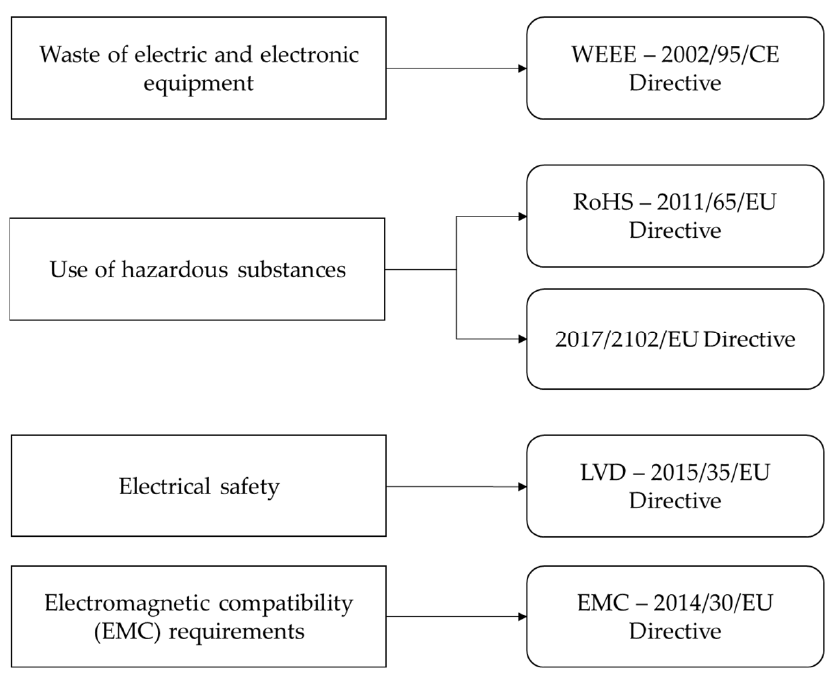
Figure 1. Directives of general application to be considered in the development of BPL electronic devices.